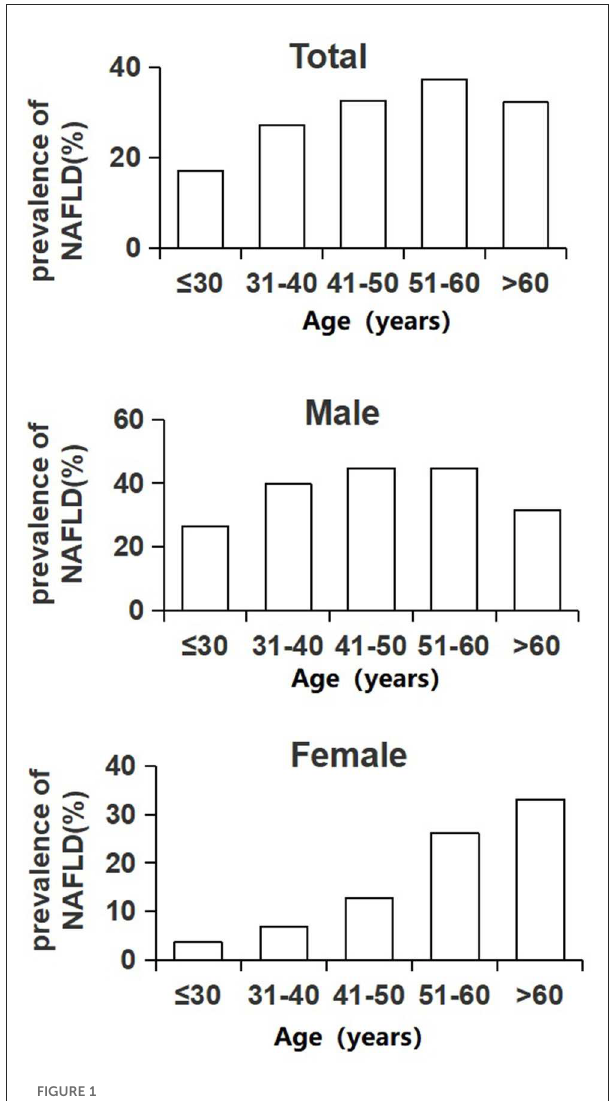
FIGURE1 Prevalence of NAFLD in different age groups.